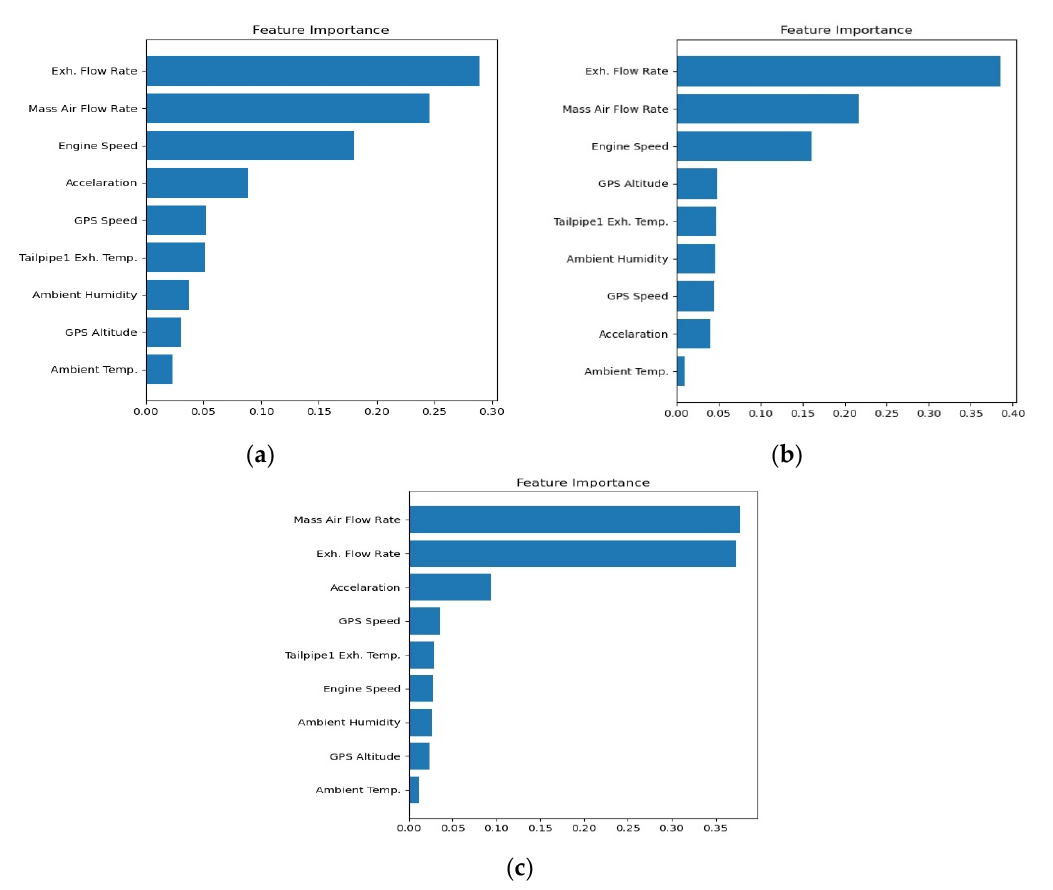
Figure 7. Feature importance detailed scores of CO 2 model ( a ) Urban; ( b ) Suburbs; ( c ) Highway. Table 8. Feature importance rank of urban, suburbs, and highway CO 2 model.